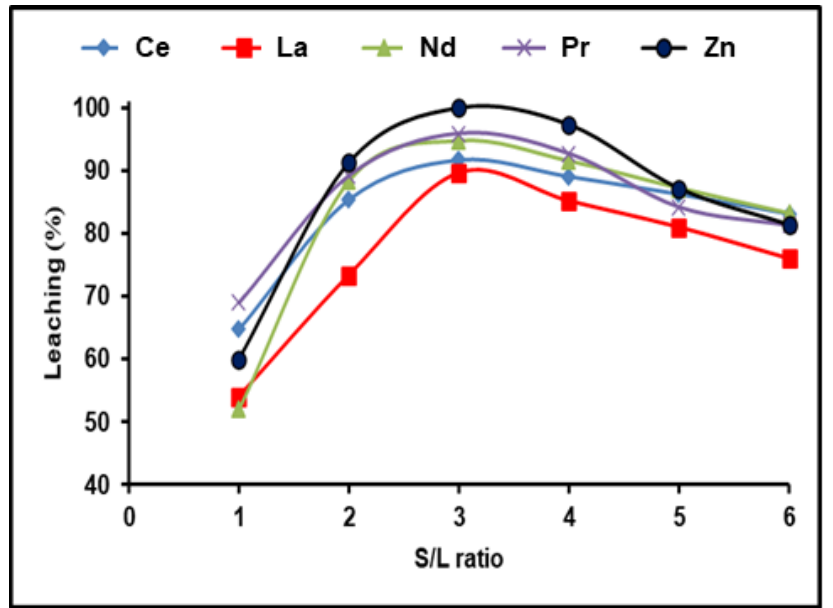
Figure 4. Influence of S/L ratio on the dissolution of REEs and Zn from spent Ni–MH battery powder (300 g/L (NH 4 ) 2 SO 4 , T: 90 °C, t: 180 min).